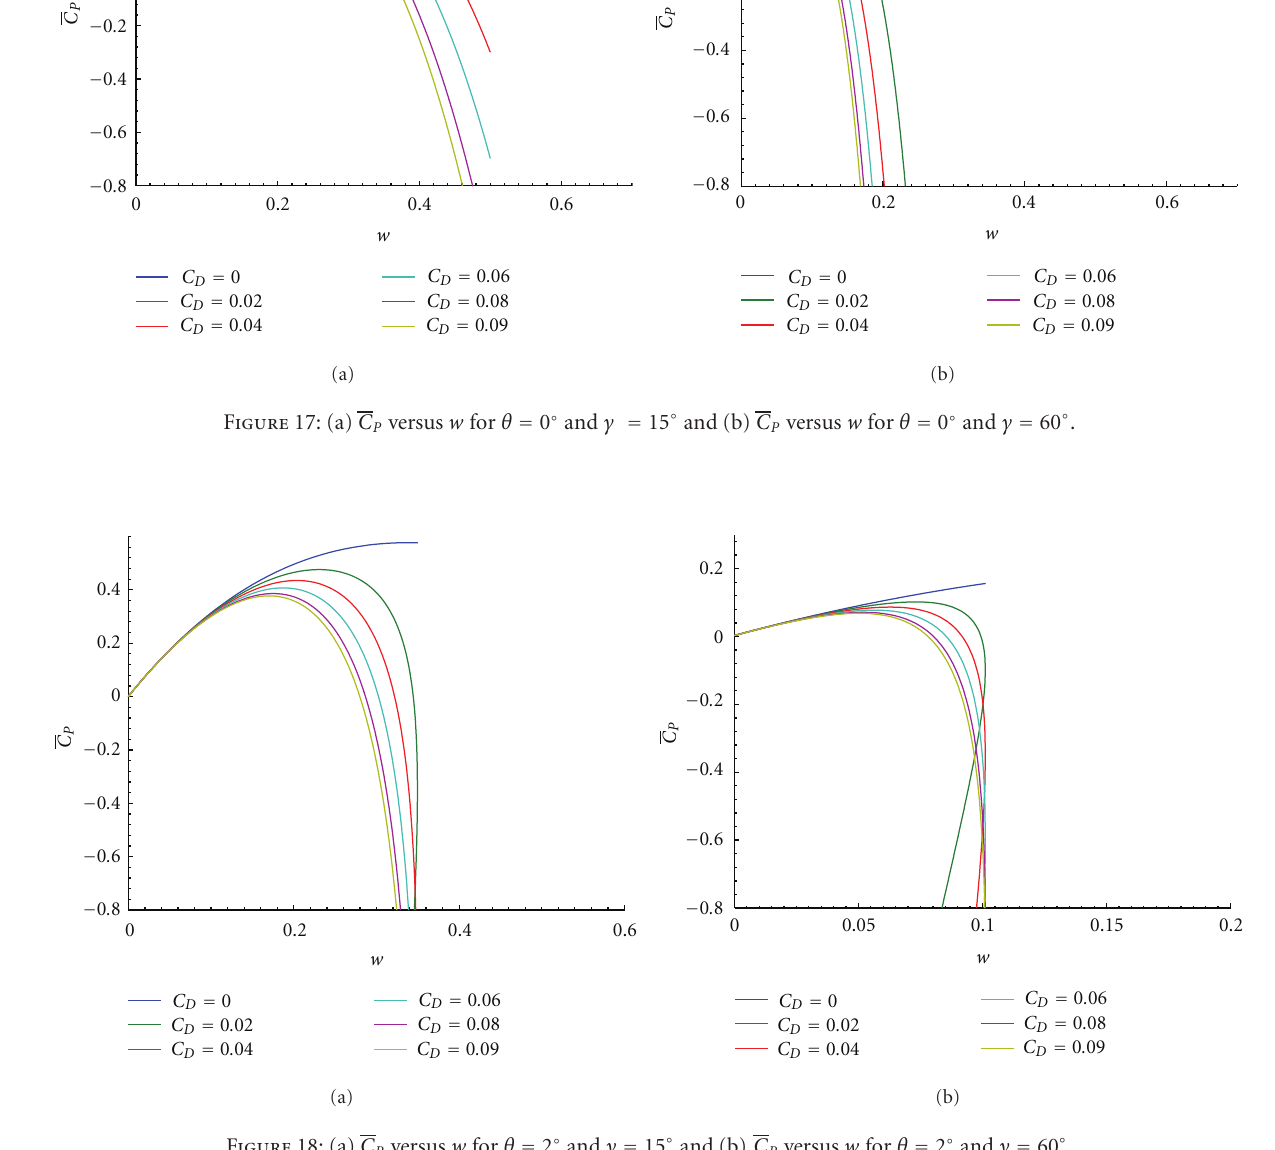
Figure 18: (a) C P versus w for θ = 2 ◦ and γ = 15 ◦ and (b) C P versus w for θ = 2 ◦ and γ = 60 ◦